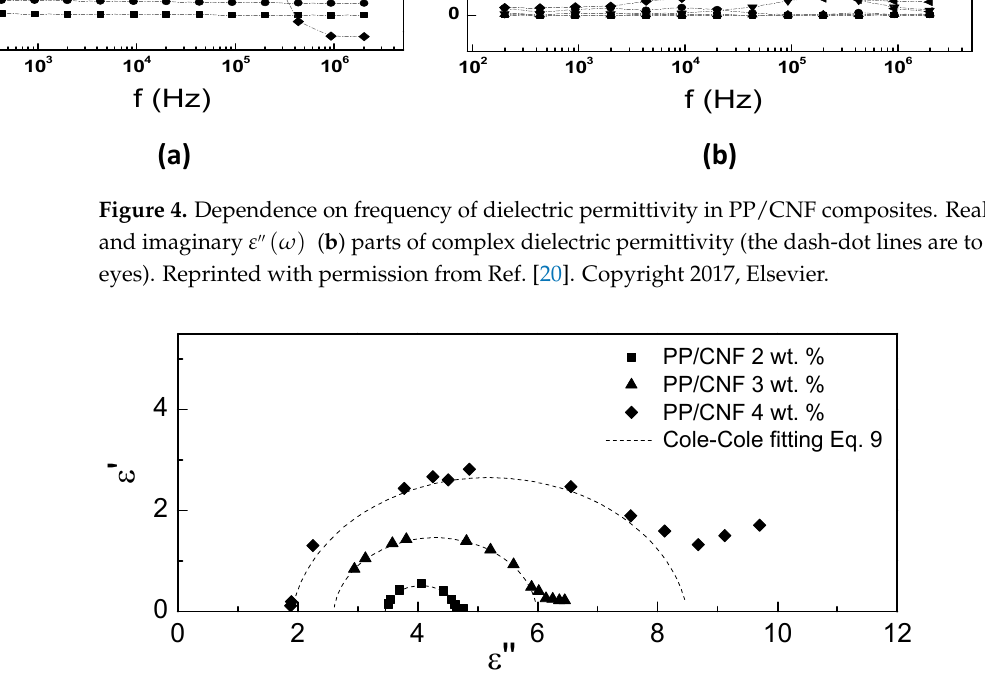
Figure 5. Cole–Cole plots for PP/CNF composites with three wt. % concentrations of CNFs (the dash ‐ dot curves represent the fitting of the Cole ‐ Cole model using Equation (9)). Table 2. Parameters 𝜏 , ( ε s − ε ∞ ) and 𝛼 of PP/CNF composites extracted by the Cole–Cole model using Equation (9).